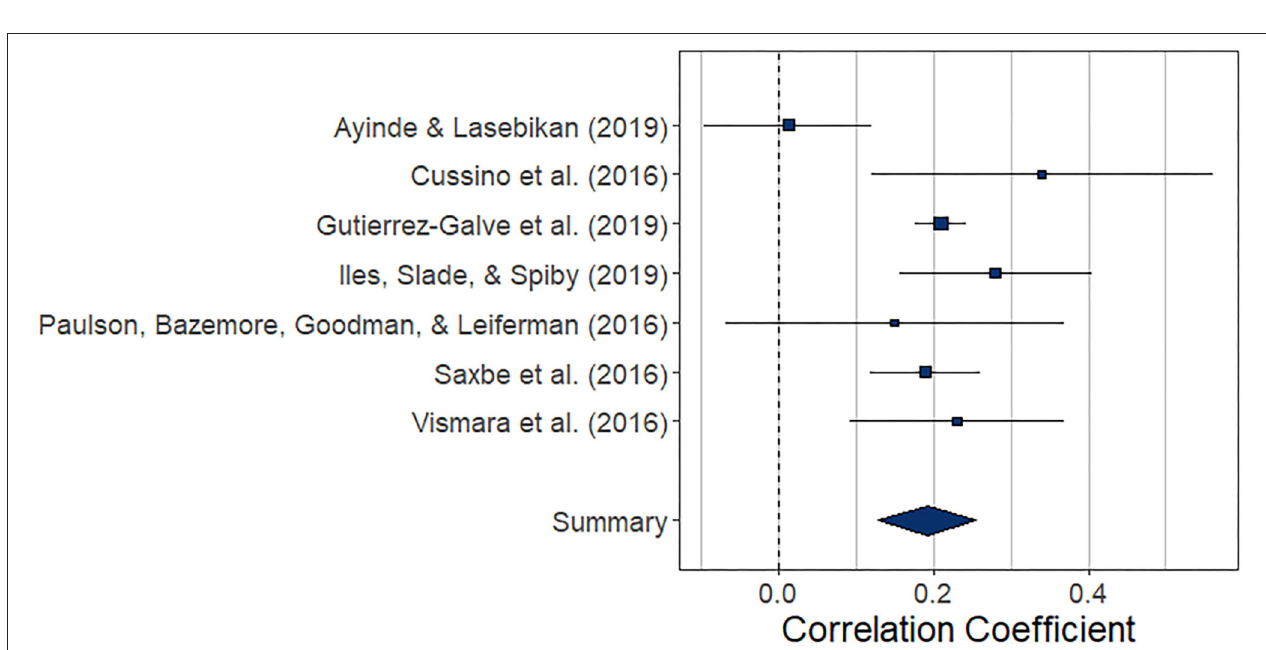
FIGURE 6 | Forest plot of the analysis of the prospective association between paternal depression at one timepoint and maternal depression at a later timepoint during the perinatal period. Weighted effect size and 95% CI are presented on the right.